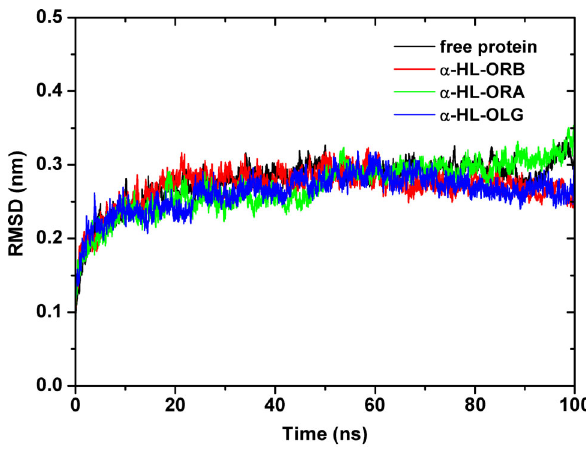
Figure 2. RMSD of the protein backbone, residues 1-293. The RMSD value is averaged over the free a -HL monomer and three a -HL-